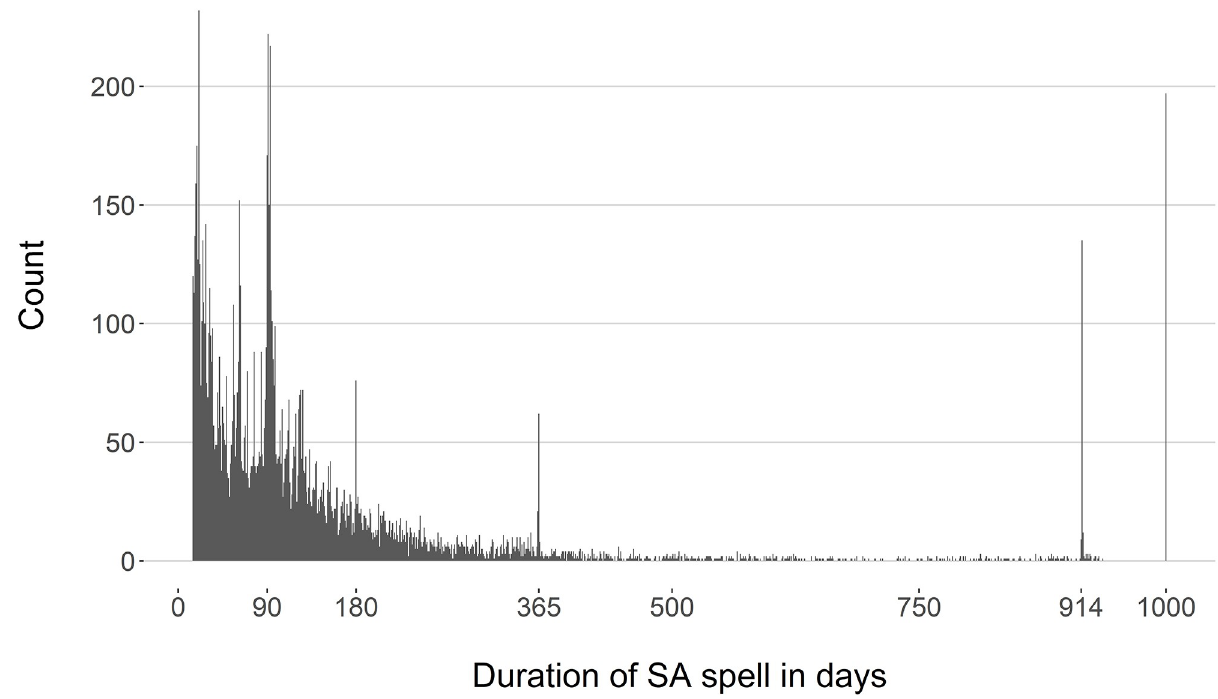
Fig 1. Histogram of the distribution of sickness absence spells (SA spells).